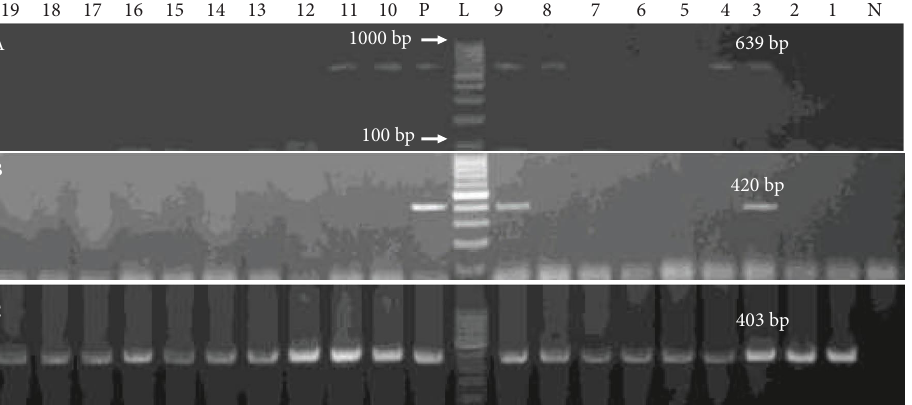
Figure 2: Molecular identifcation of macrolide resistance genes. PCR amplifcation of (a–c) macrolide resistance genes ermB, ereA, and